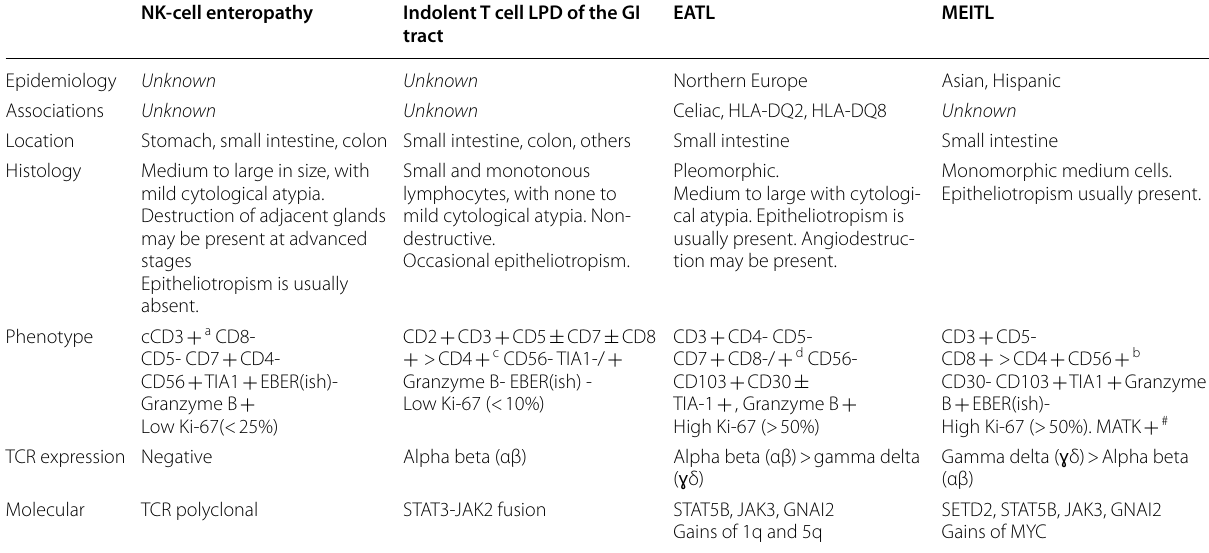
a Concurrent flow cytometry analysis demonstrates that CD3 expression is cytoplasmic b Majority of tumors (~ 80%) are CD8 , a small subset of cases (9–18%) can be negative for CD56 + c Majority of the cases are CD8 (~ 80%), a minority of the cases are either CD4 or double CD4/CD8 negative in similar proportions + + d Approximately 30% of the cases are CD8 , majority of the cases are CD4-/CD8-. # MATK/Lsk nuclear expression is detected in majority of MEITL cases and in NK/T + cell lymphomas, whereas EATL cases only feature cytoplasmic